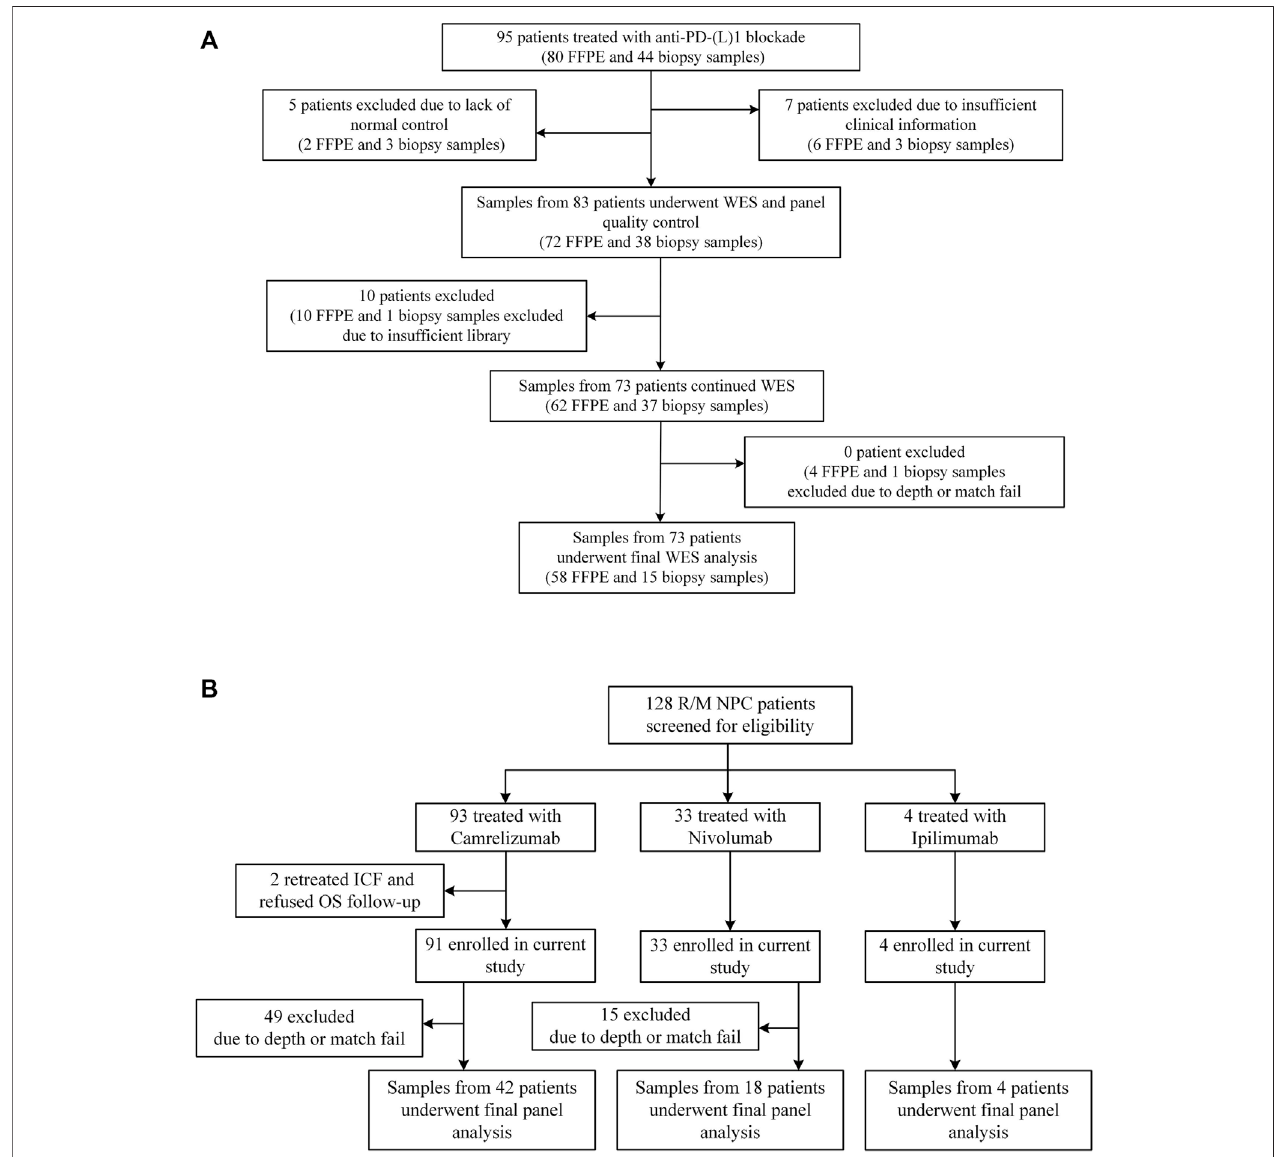
FIGURE 3 | Patient samples included in the fi nal analysis. (A) Flowchart for NSCLC sample inclusions. Among the 95 patients who underwent anti-PD-(L) 1therapiesandhadavailableFFPEand/orbiopsytumorsamples,weperformedWESonsamplesfrom73patients. (B) FlowchartforNPCsampleinclusions.Amongthe 128 patients who underwent anti-PD-(L) 1 or anti-CTLA-4 therapies, we performed targeted NGS on samples from 64 patients.